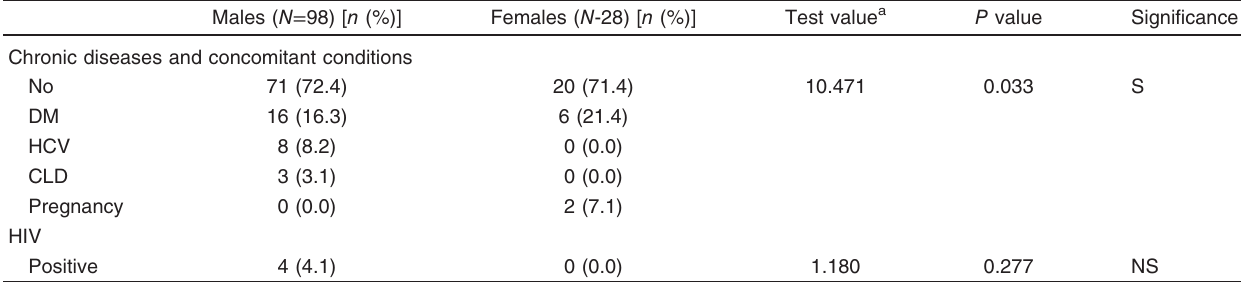
Table 4 Comparison between concomitant disease between females and males Males ( N = 98) [ n (%)] Females ( N -28) [ n